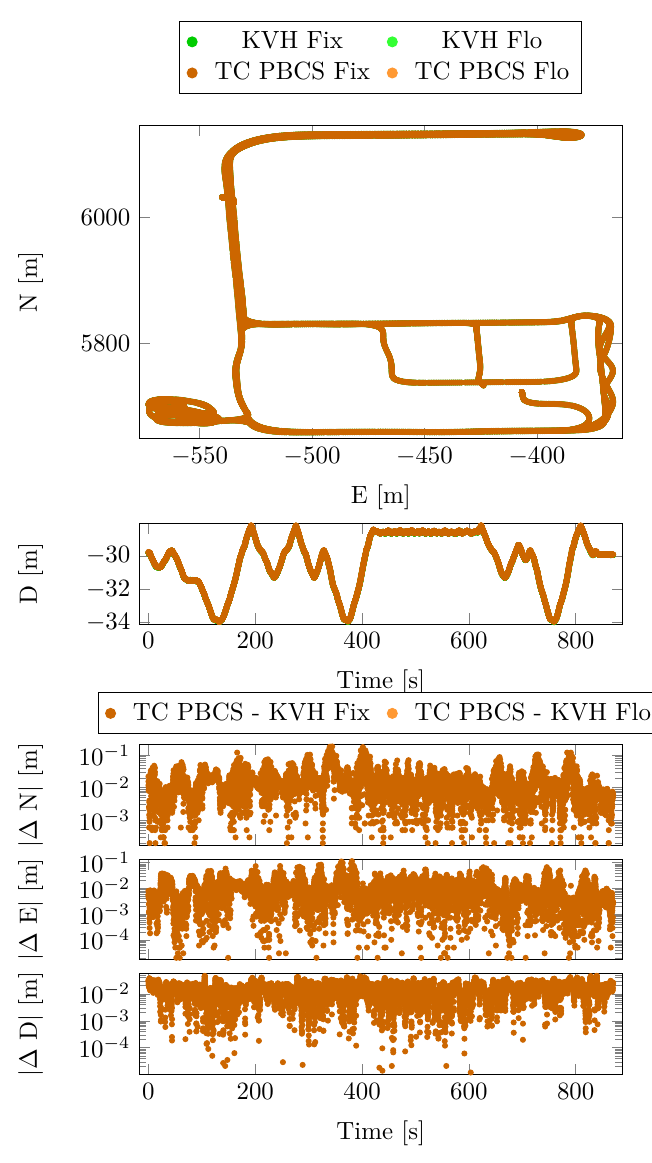
Figure 6. Position and position differences from reference—Case Study